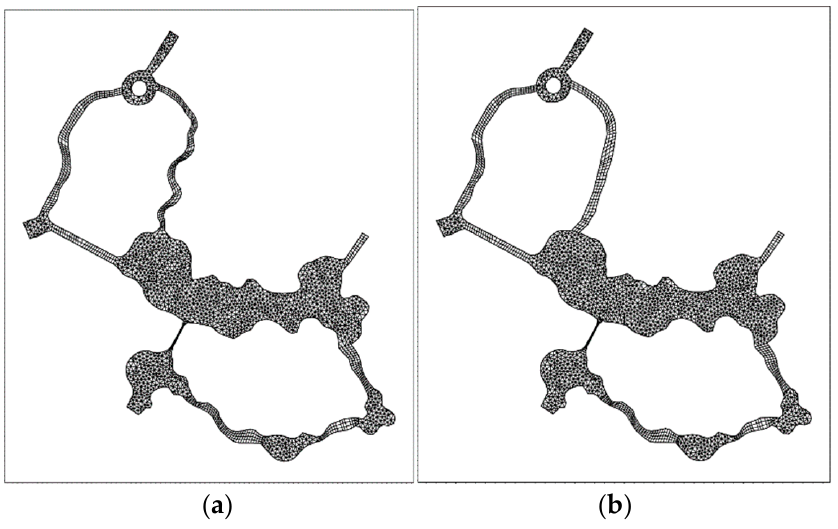
Figure 3. ( a ) Original planning “bilateral” river grid, ( b ) proposed “bilateral” river grid.